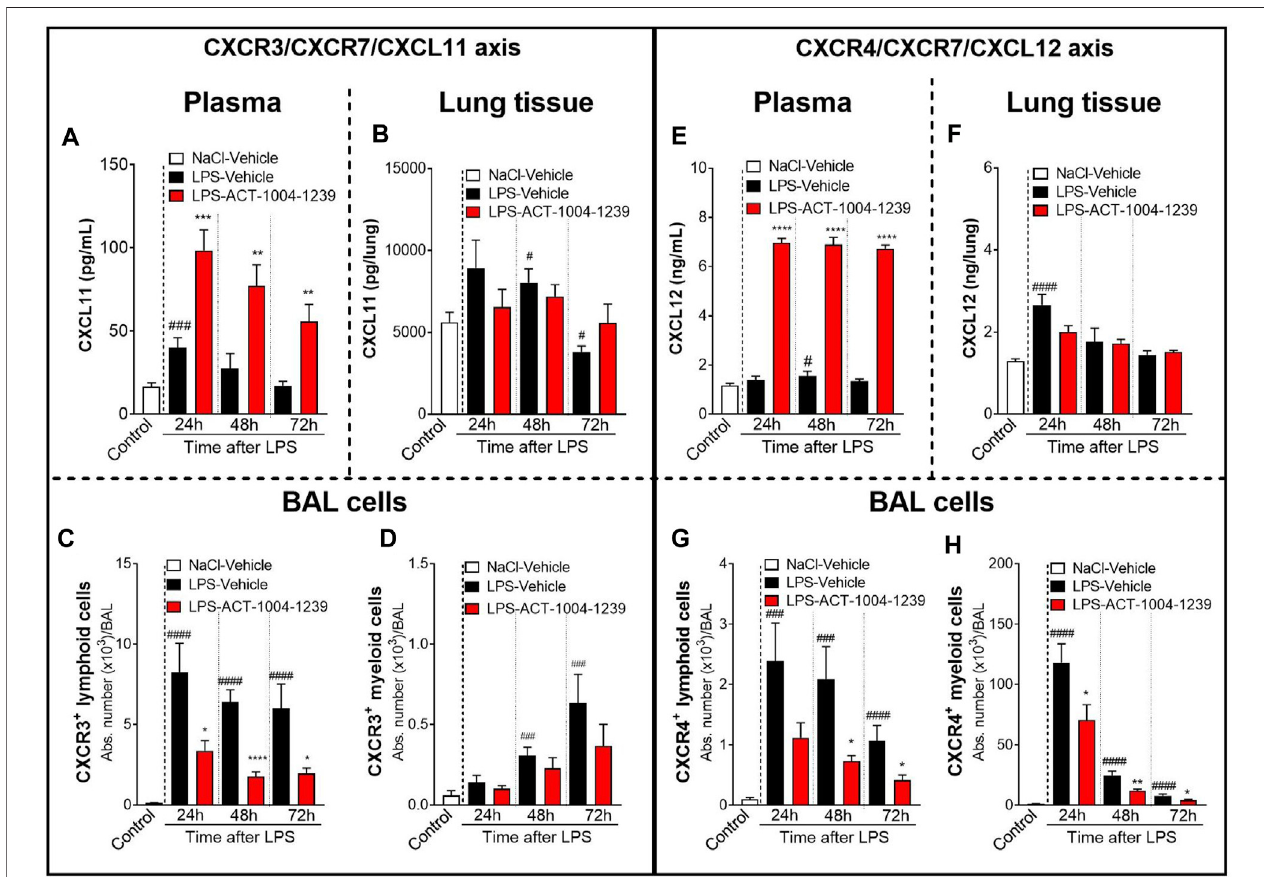
FIGURE 3 | Antagonism of CXCR7 increases plasma CXCL11 and CXCL12 levels and decreases CXCR3 + and CXCR4 + BAL in fi ltrates post LPS challenge. ALI was induced by nebulized LPS inhalation, and DBA/1 mice were treated with vehicle (LPS-vehicle, black bars) or ACT-1004-1239 (LPS-ACT-1004-1239, 100 mg/kg, red bars) orally, twice daily, 1 h prior to LPS challenge. Control mice received vehicle 1 h prior to NaCl 0.9% inhalation (NaCl-vehicle, white bars; n (cid:1) 12 mice, pool of all time points). Protein concentrations of CXCL11 and CXCL12 in the plasma and lung tissue and BAL fl ow cytometry of immune in fi ltrates were performed 24, 48, and72 hafterchallenge( n (cid:1) 6 – 8micepertimepoint).TimecourseofCXCL11proteinconcentrationintheplasma (A) andlungtissue (B) .Chemokineconcentrationsare expressed inpg/ml(plasma)orpg/lunghomogenate(mean ± SEM).** p < 0.01,*** p < 0.001versusLPS-vehicle-treated animalsor # p < 0.05, ### p <